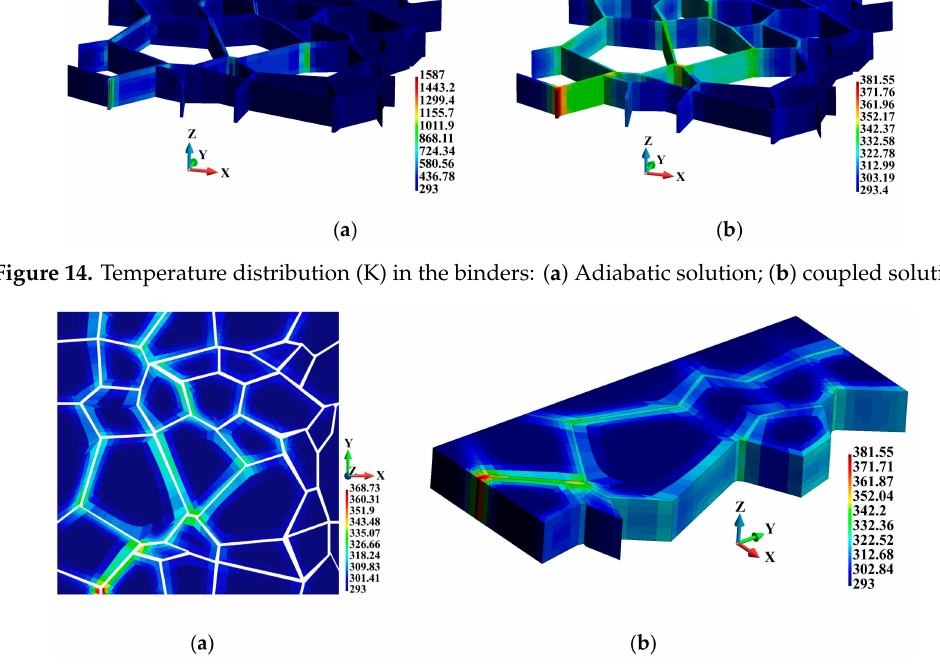
Figure 15. Temperature distribution (K), coupled solution: ( a ) Grains; ( b ) cross section along the